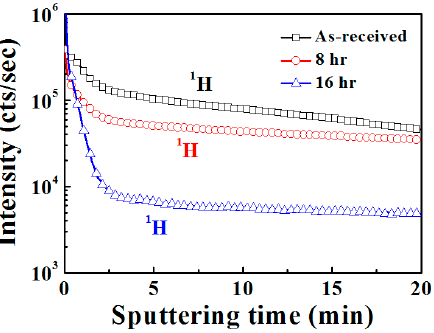
Figure 5. A depth profile of Hydrogen content in 10B21 steel after baking at 215 °C for different durations.